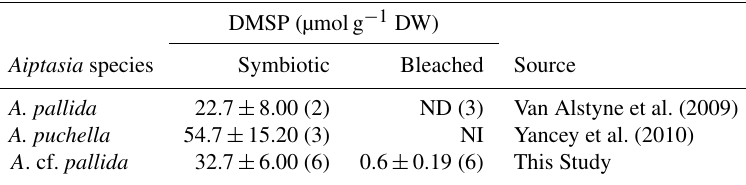
Table 3. Biomass-normalised DMSP within symbiotic or bleached anemones (mean ± SD) in this and two previous studies. Sample size ( n ) in parentheses. DMSP, dimethylsulfoniopropionate; DW, dry weight; ND, not detectable; NI, not